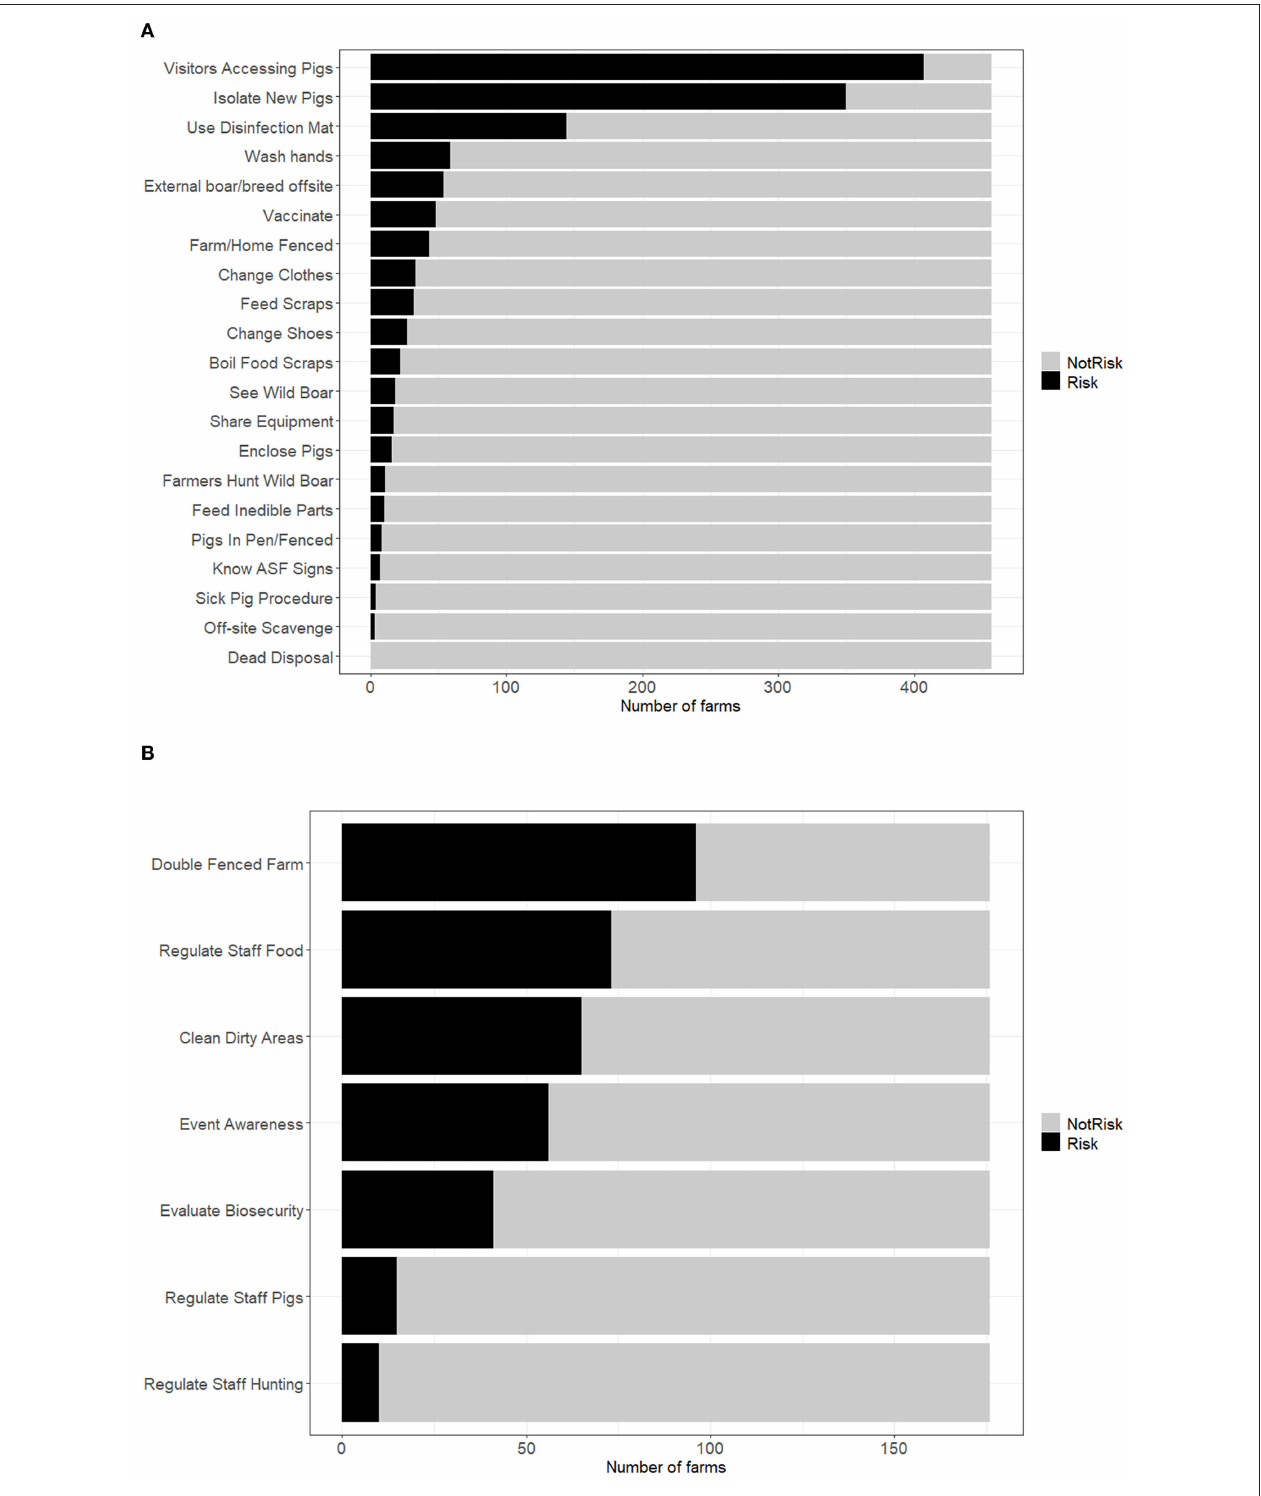
FIGURE 5 | Dichotomous scoring responses for questions administered to North Macedonian pig producers between September 2019 and March 2020, characterizing reported practices as no/low risk vs. contributing risk for ASF introduction based on biosecurity characteristics for (A) all farms, and (B) family and commercial farms. Scores were used to calculate biosecurity risk scores. “Not risk” answers were assigned a score of zero, “risk” answers were assigned a score of one. Two separate sets of biosecurity risk scores were developed to account for additional information provided in a subset of biosecurity questions that was only answered by family and commercial